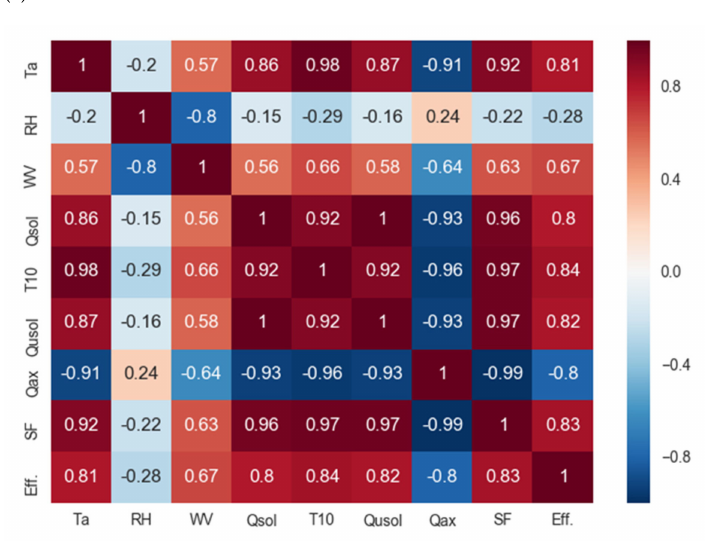
Figure 11. Sensitivity